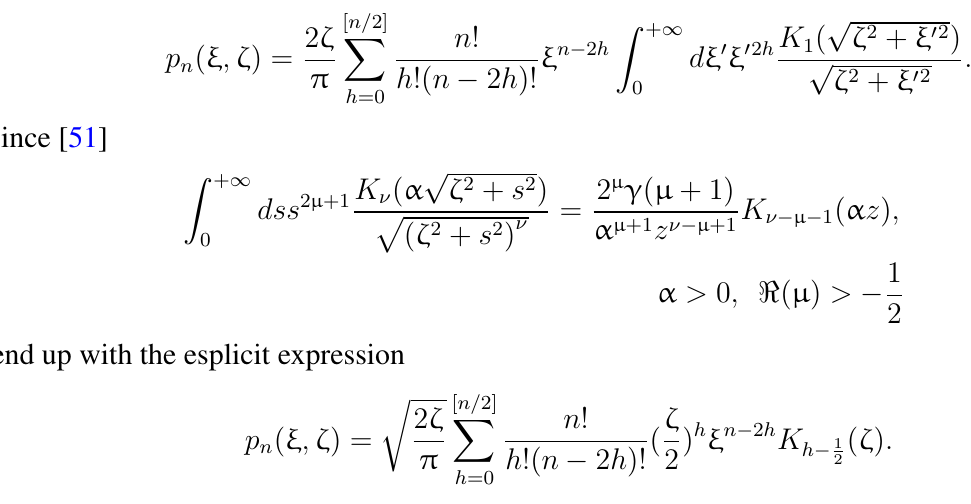
Figure 7. ξ -profiles of ψ ψ ( ξ , ζ , ε = 1) (green dashed line), ψ D ψ ( ξ , ζ , ε = 3) (turquoise thick solid line) at different ζ , specifically at ( a ) ζ = 0 , D ( b ) ζ = 0 . 5 , and ( c ) ζ = 1